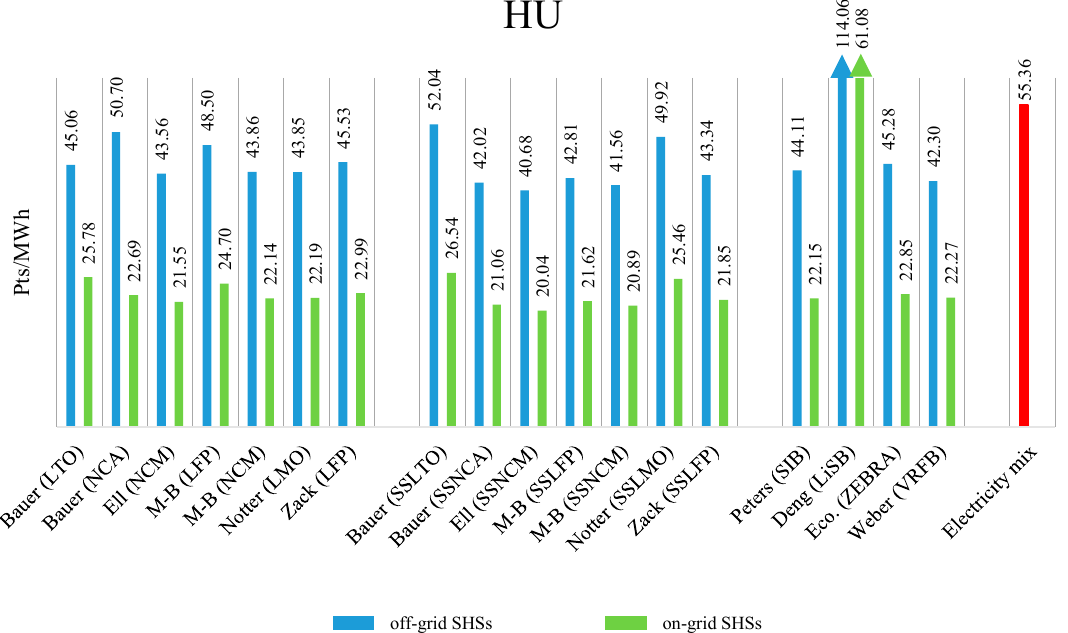
Figure 10. LCA impact values of SHSs in Italy as single scores.